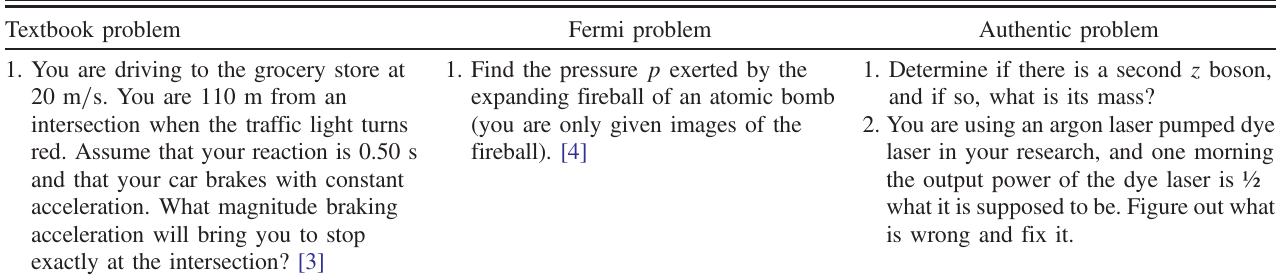
TABLE I. Example of a textbook problem that students might encounter in an undergraduate physics course vs an example of a problem Enrico Fermi solved vs an example of an authentic problem that an expert physicist would encounter in their work. Textbook